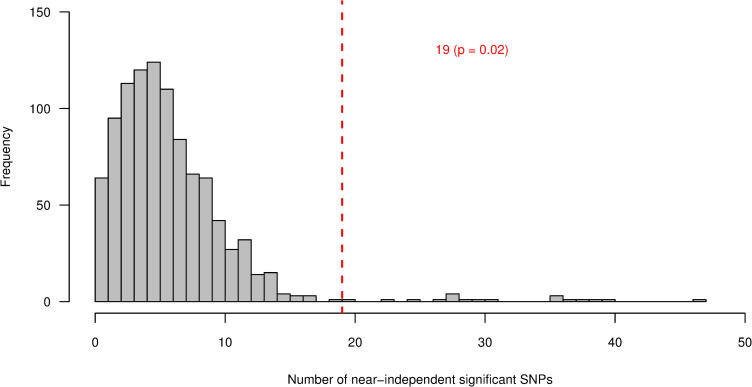
Frequency distribution of the number of SNPs with near-independent significant effect on stature (P < 5x10-8) in 1,000 control tests for SMR-MT-C genes.In each test, 121 cattle genes were sampled from a total of 13,865 genes that have human orthologs. Stratified random sampling was carried out, with genes stratified based on gene-size. The number of near-independent significant SNPs within and 100k either side of the sampled genes were identified. The vertical dashed line represents the number of near-independent significant SNPs (P < 5x10-8) associated with stature, identified within and 100kbp either side of the 121 cattle (SMR-MT-C) candidate genes, whose human orthologues show evidence of differential expression in 3 or more tissues. The p value represent the proportion of samples (out of 1,000) that have equal or higher level of enrichment for GWAS hits than the SMR-MT-C genes.